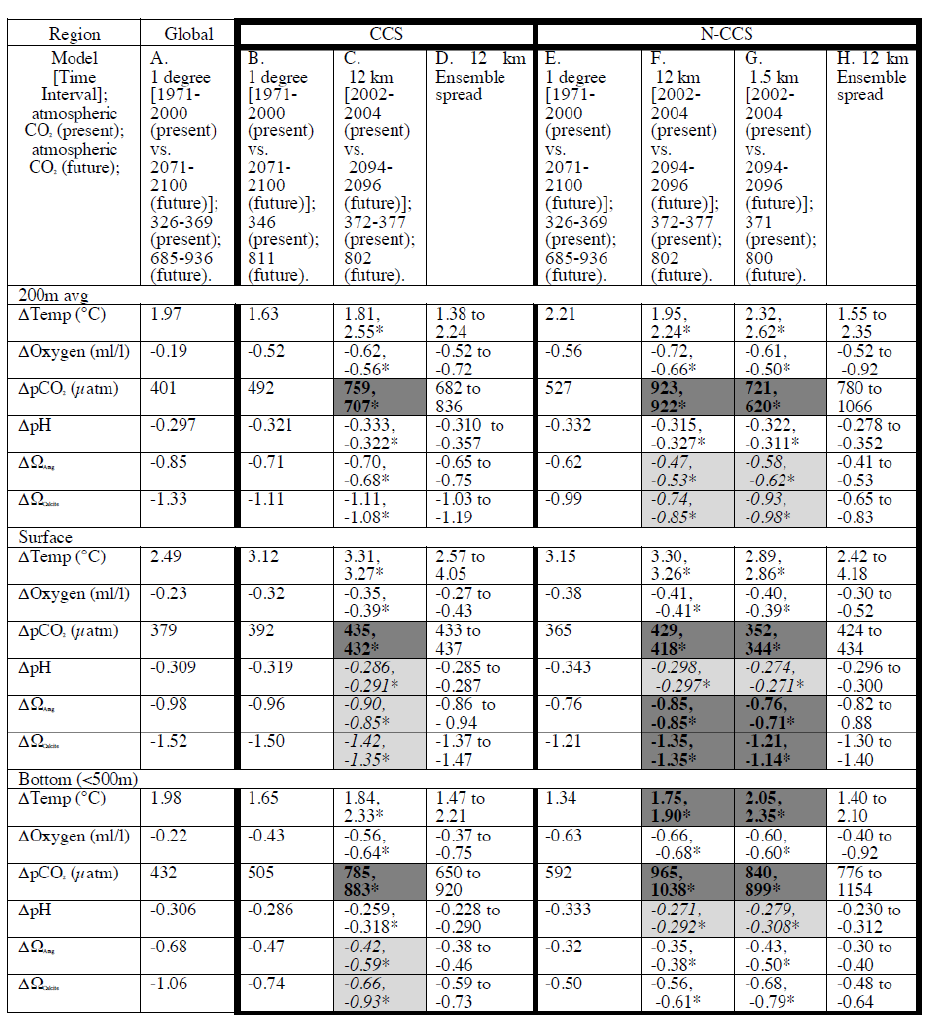
Table 1. Annual average differences between climate stressor variables in the future and the base/present conditions for the global ensemble and 12 and 1.5km projections over different regions of the water column (200m averaged, surface, and bottom < 500m). Column A depicts the global average from the ensemble average of CMIP5. Column B includes the global (1 ◦ ) ensemble average difference for the CCS region followed by, in column C, the CCS-wide difference from the 12km downscaled results. The final CCS column (column D) includes the ensemble spread as the range across the five-member model spread of the results for the 12km model projections column for the CCS domain. The N-CCS region results span columns E–H in this table. The next three columns detail the differences in the Cascadia domain for the global ensemble average (column E) and the 12km (column F) and 1.5km downscaled projections (column G). The final column (column H) includes the ensemble spread as the range across the five-member model spread of the results for the 12km model projections column for the Cascadia domain. The direction with which each variable described above was amplified/dampened relative to the global models outside the ensemble variability is highlighted using bold text and dark grey (amplified) and italic text with light grey (dampened) shading. Within the downscaled simulation, values are also provided just on the shelf ( < 200m isobath) and denoted with an asterisk (*) next to the